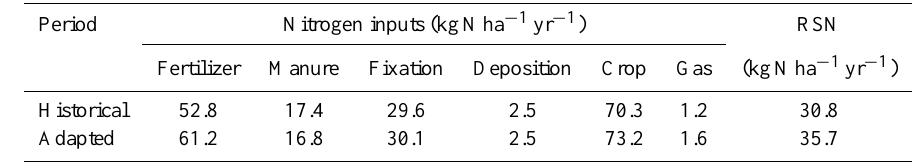
Table 8. Average components of the nitrogen balance as simulated with historical crop and animal husbandry practices and with an adapted agricultural management scenario (De Jong et al., 2008).